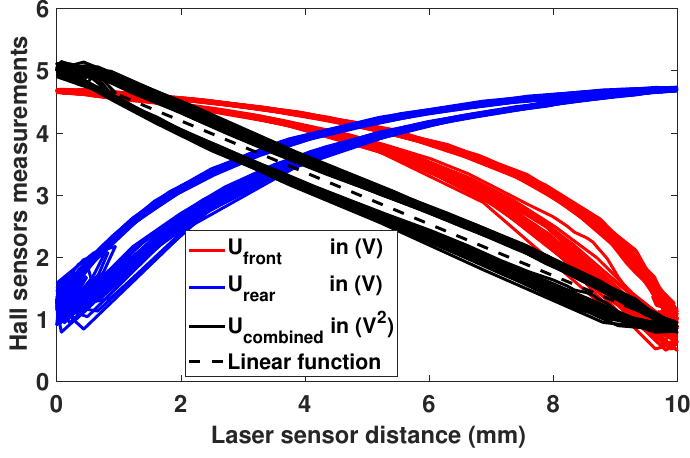
Figure 7. Position sensor measurements: several fast up-and-down